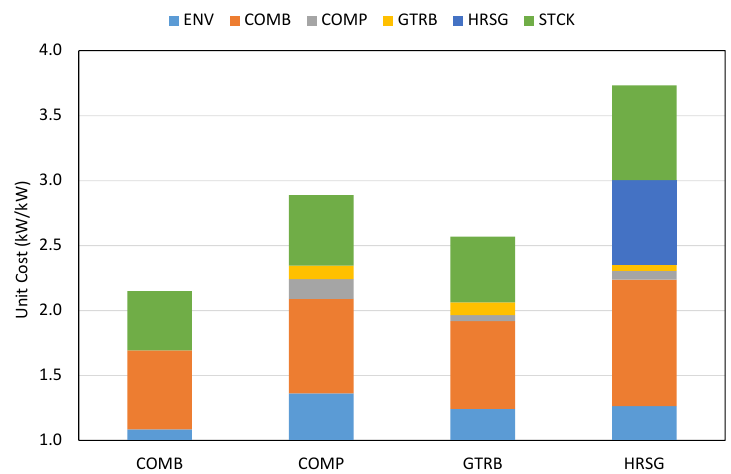
Figure 8. Generalized irreversibility–cost decomposition graphics for TGAS